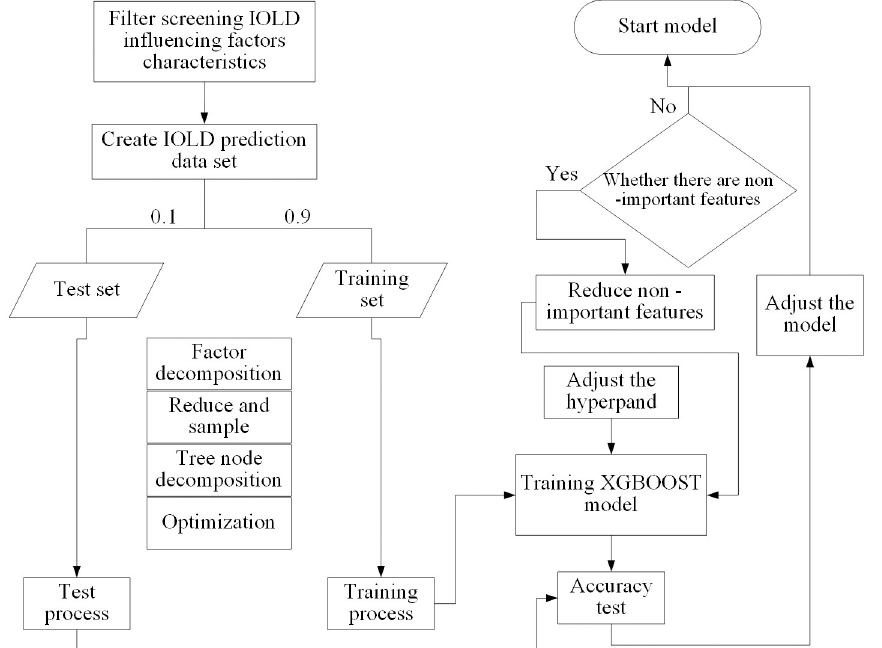
Fig 5. Modeling flowchart of XGBOOST based on land development